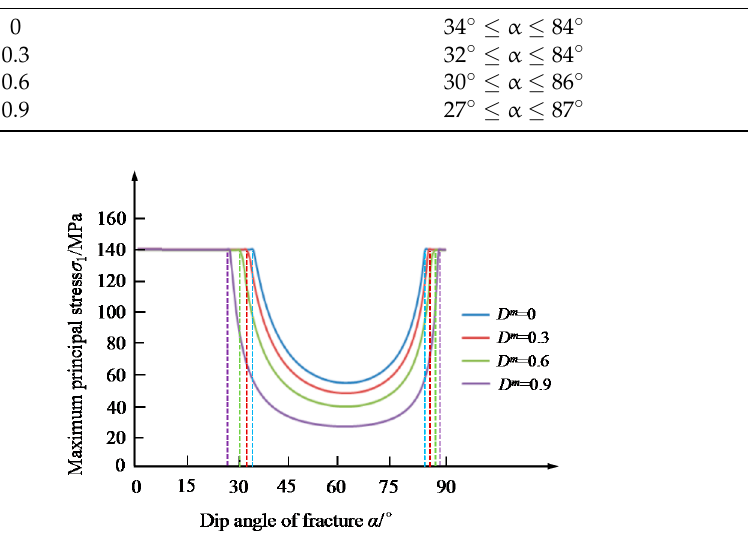
Table 3. Dip angle of rock slipping along the failure face with different water-dripping erosion factors. Water-Dripping Erosion Factors D m